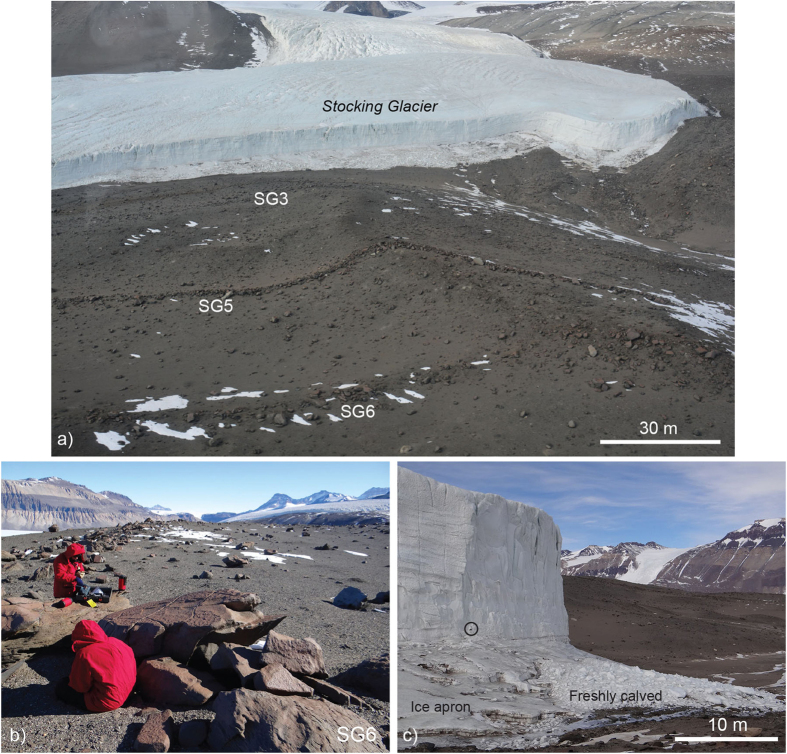
(a) Oblique aerial photograph of Stocking Glacier margin. Note ice cliff, ice apron and the lack of significant supraglacial, englacial, or basal debris. Moraines SG3, SG5 and SG6 (the outermost moraine) are visible. (b) Ground photograph of the outermost moraine (SG6), looking west toward Taylor Dome; note small-scale pitting, wind faceting and oxidation of boulder surfaces. (c) Close-up view of the terminus of modern Stocking Glacier, showing ice cliff, ice apron and freshly calved ice blocks. Black circle shows an entrained clast. Melting along solar heated rocks and sand grains is sufficient to produce small meltwater streams that drain southward toward Taylor Glacier (see also Fig. 1). All images courtesy of K.M. Swanger, reprinted with permission.